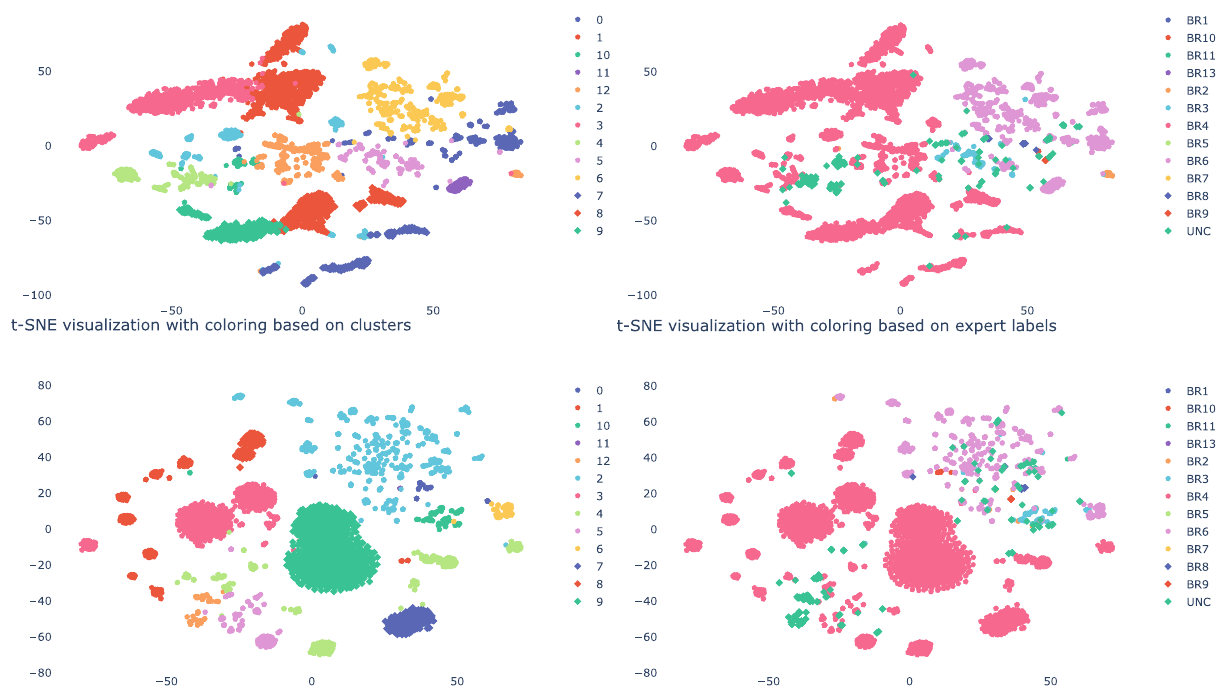
Figure 4. Here we show the t-sne visualization for company B obtained with finWalk (top) and DeepWalk (bottom), with on the left the clusters as indicated by the agglomerative clustering algorithm and on the right the expert’s